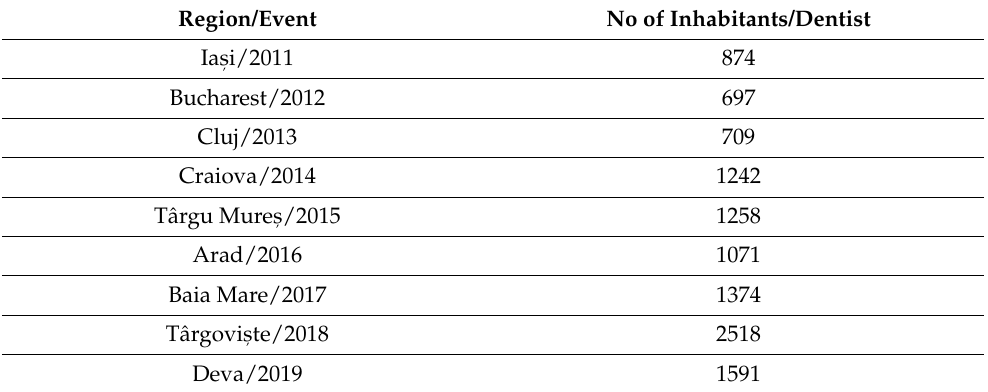
Table 1. Number of inhabitants per active dentist in the respective cities of the SO-SS events as reported by the Romanian National Centre for Statistics and Informatics in Public Health in 2016 for 2014.